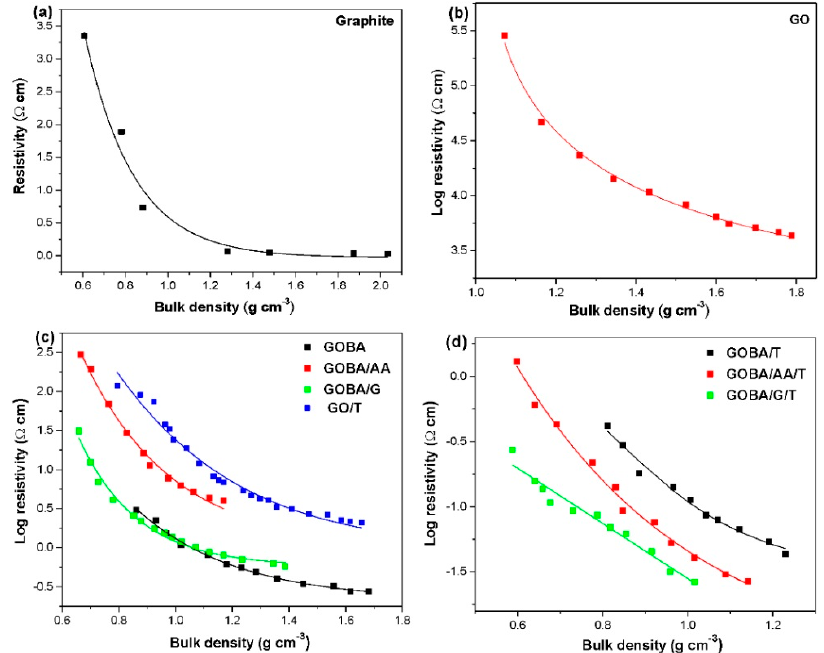
Figure 5. Specific resistivity dependence on bulk density for graphite ( a ), GO ( b ), GO/T and mrGO ( c ) and trGO ( d ).